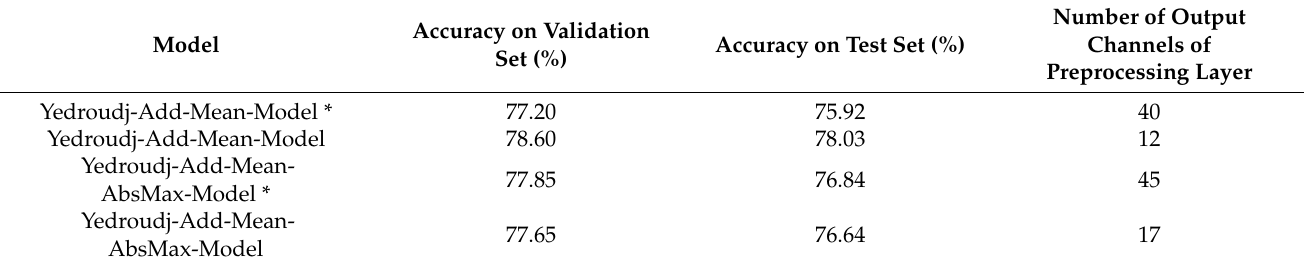
Table 4. Accuracy of different fusion methods.